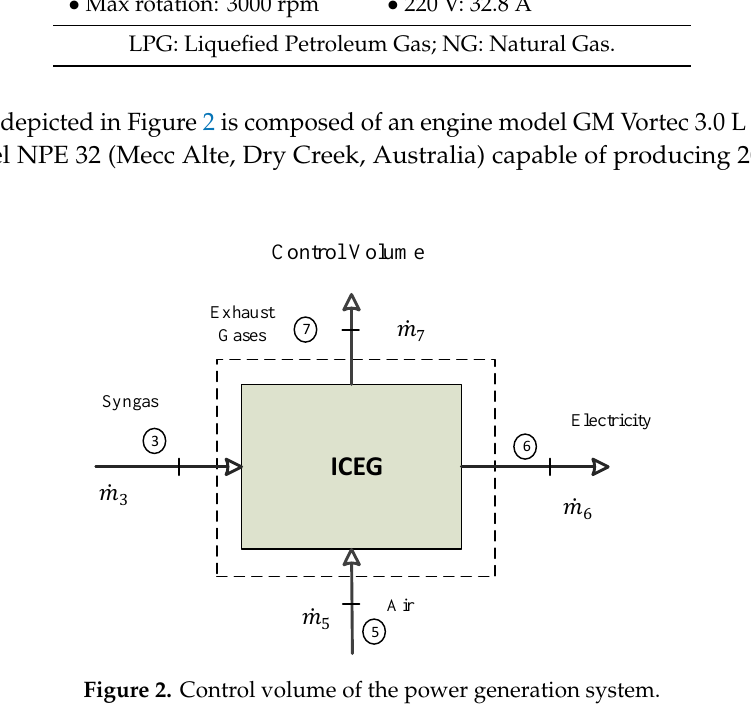
Table 3. Chemical composition of the used fuels.